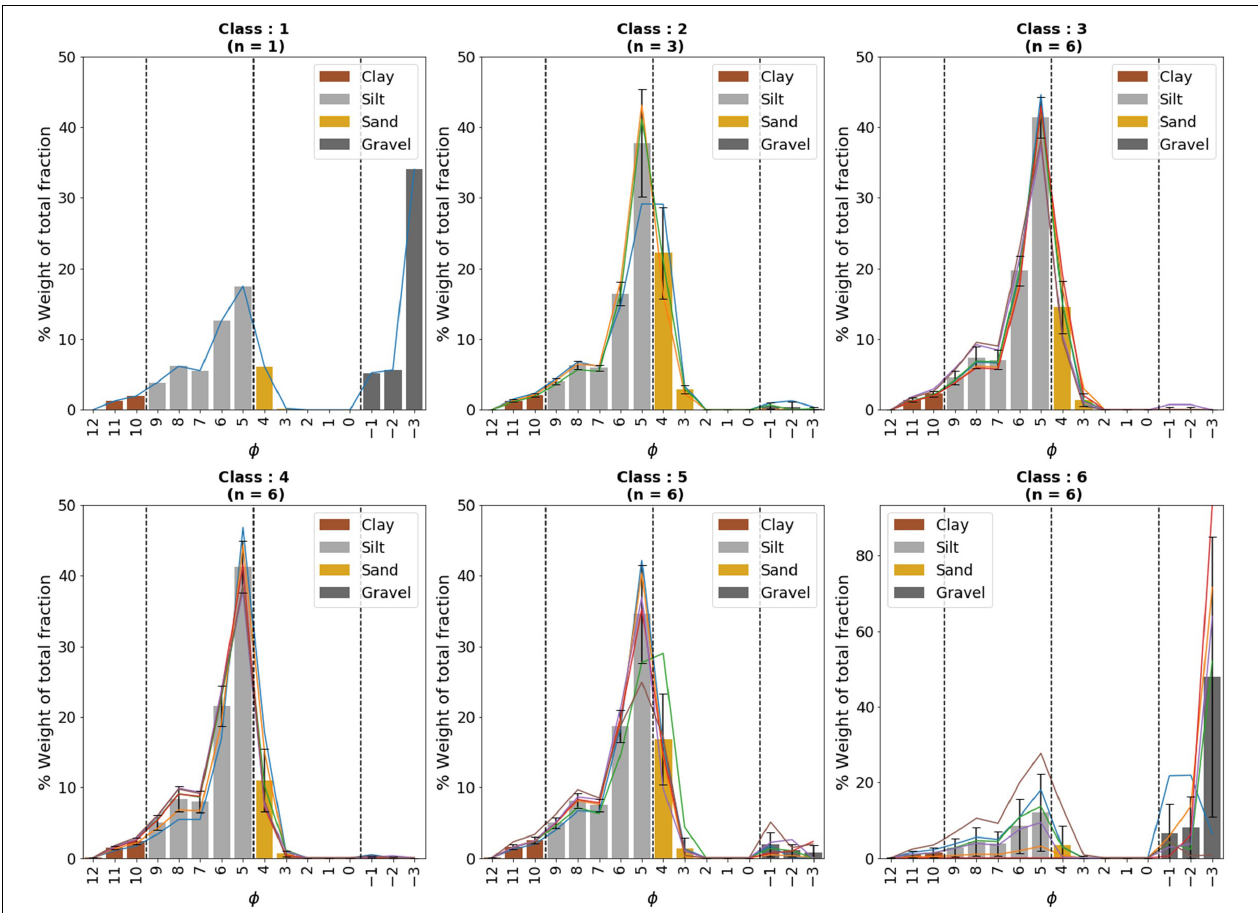
FIGURE 7 | Loch Creran sediment particle size distributions converted to phi scale for each class output from the Unsupervised Iso-cluster Classification. For each class, the continuous lines show the grain size results for individual samples and the frequency histograms show the composite mean results at the individual size fractions for the combined number of grab samples (n). Error bars show the standard deviation at each size fraction to highlight variability. Bar colours and dashed vertical lines differentiate the proportions of clay ( > 9 ϕ ) or ( < 2 µ m), silt (8 ϕ – 5 ϕ ) or (2 µ m – 63 µ m), sand (4 ϕ – 0 ϕ ) or (63 µ m – 2000 µ m) and gravel ( < 0 ϕ ) or ( > 2000 µ m). Note that the ϕ scale has been inverted and larger grain size plot to the right. Class 6 has a different scale on the y